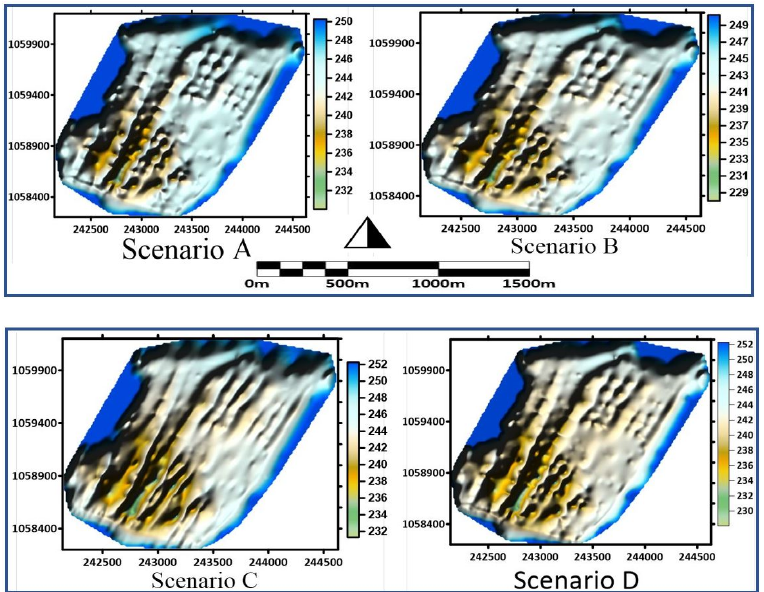
Figure 9. Digital Elevation Model of Scenarios ( A – D ) (Source: Research lab, generated from the interpolated data with a pixel size of 10 m by 10 m using Surfer 2021 software).